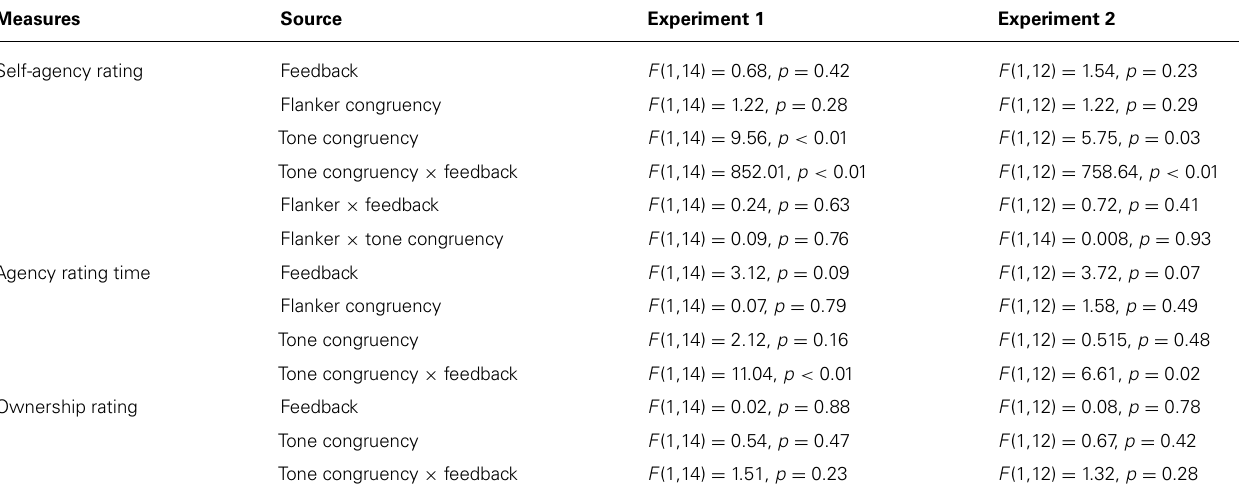
Table 2 | Repeated measureANOVA on self-agency rating, response time for agency rating, and ownership rating of Experiments 1 and 2.